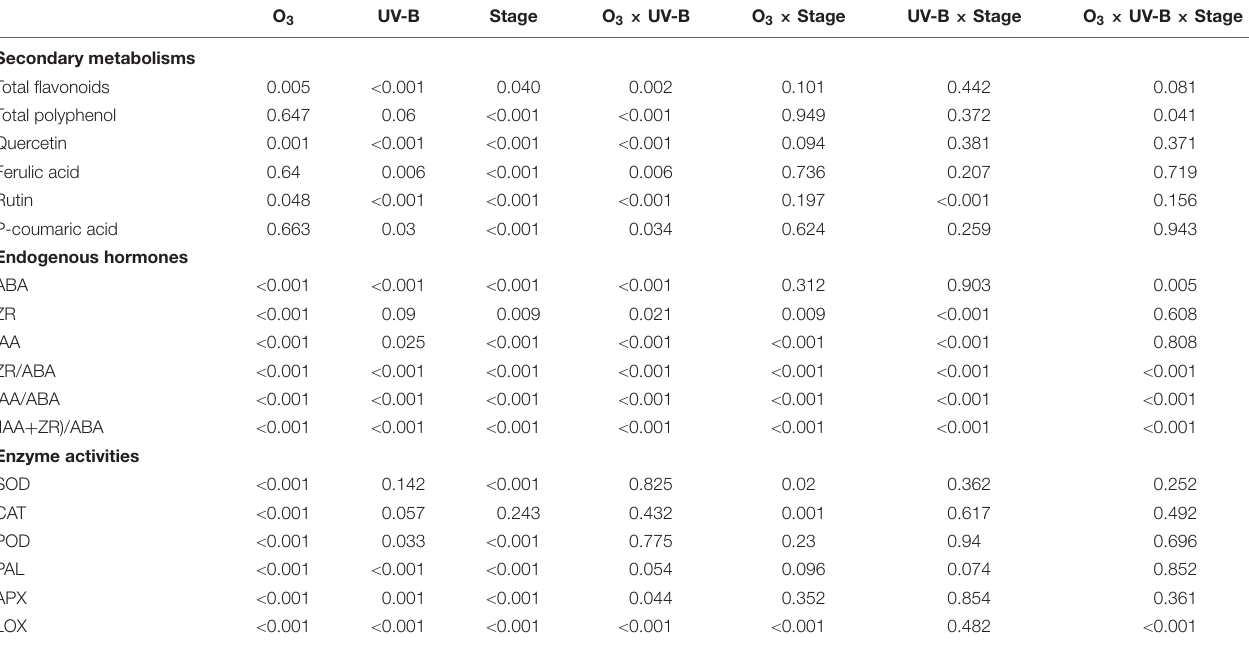
TABLE 4 | P -values of 3-way ANOVA results showing the effect of the elevated O 3 concentration, the enhanced UV-B radiation and the growth stage on secondary metabolisms, endogenous hormones, and enzyme activities of soybean roots. O 3 UV-B Stage O 3 × UV-B